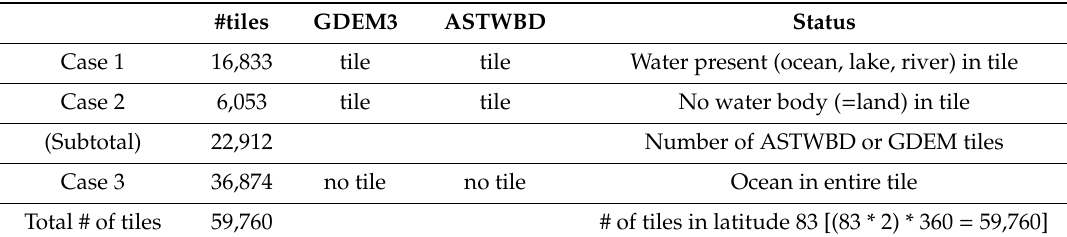
Table 4. ASTER Global Water Body Dataset (ASTWBD) and GDEM # tiles.